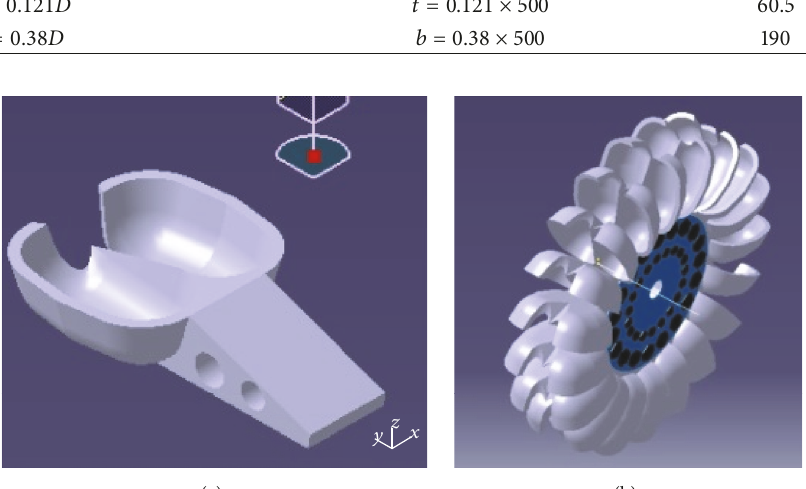
Figure 6: Solid model of Pelton turbine for the selected site data, (a) bucket and (b) 3D view of the runner